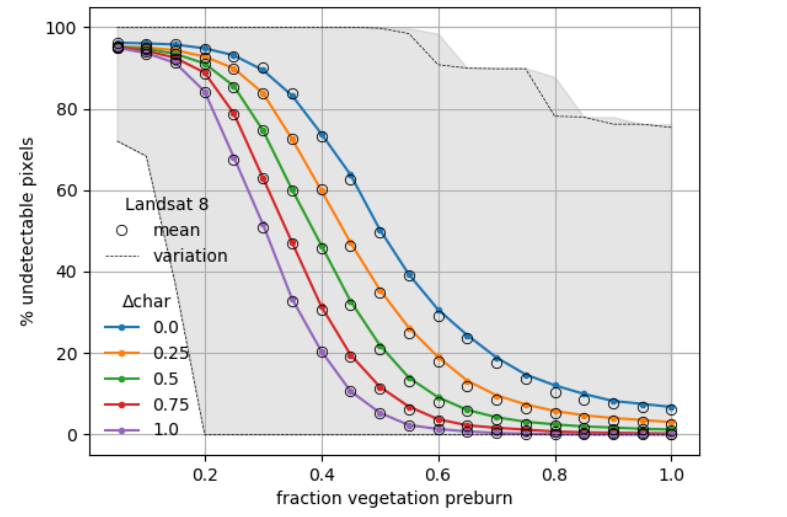
Figure A10. Percentage of undetectable pixels as a function of starting vegetation fraction and ∆ char parameter setting, park-wide for Sentinel-2B, dNBR threshold = 0.15. Mean values are shown in colored lines, with total model result variation shown in gray. To compare, the results for Landsat 8 are shown in black, with mean values shown by circles and total model result variation shown by dashed